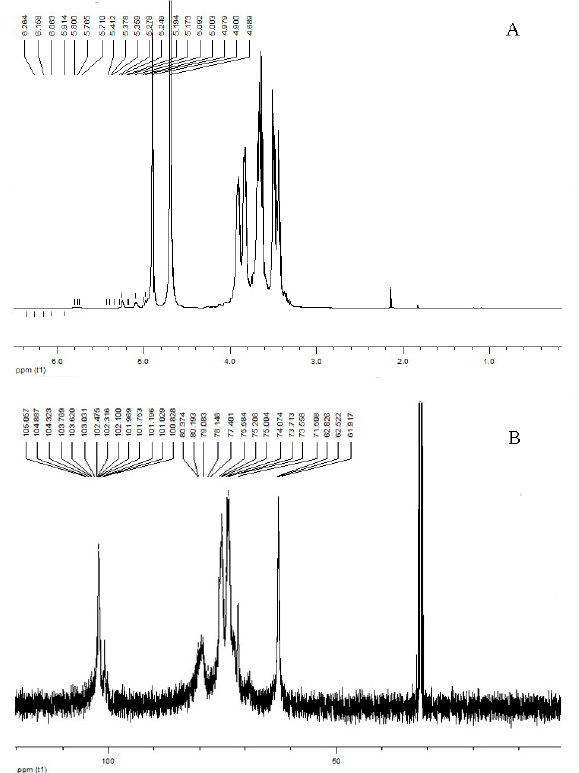
Figure 3. NMR spectra of the B. exarata polysaccharide-protein complex BEPS-IA in D 2 O. ( A ) 1 H-NMR and ( B ) 13 C-NMR.